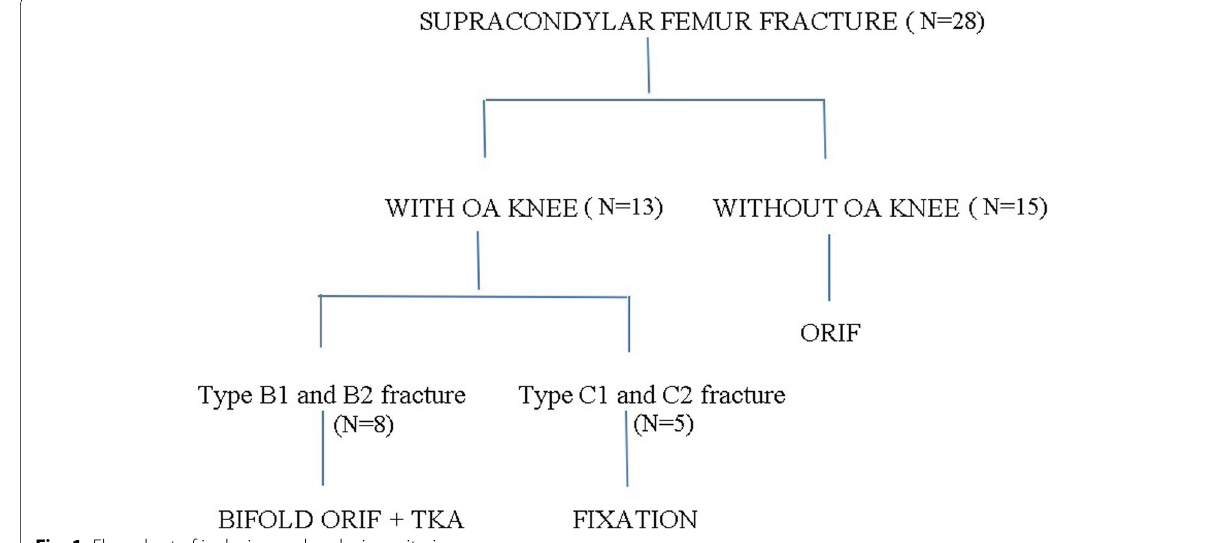
Fig. 1 Flow chart of inclusion and exclusion criteria